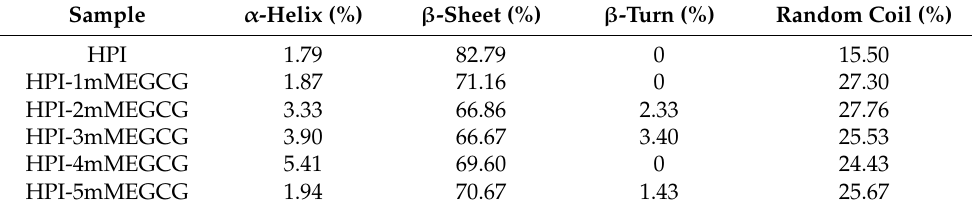
Figure 2. Far-UV CD spectroscopy of HPI and HPI-EGCG conjugates. Table 2. Secondary structure contents of HPI and HPI–EGCG conjugates. Table 2. Secondary structure contents of HPI and HPI–EGCG